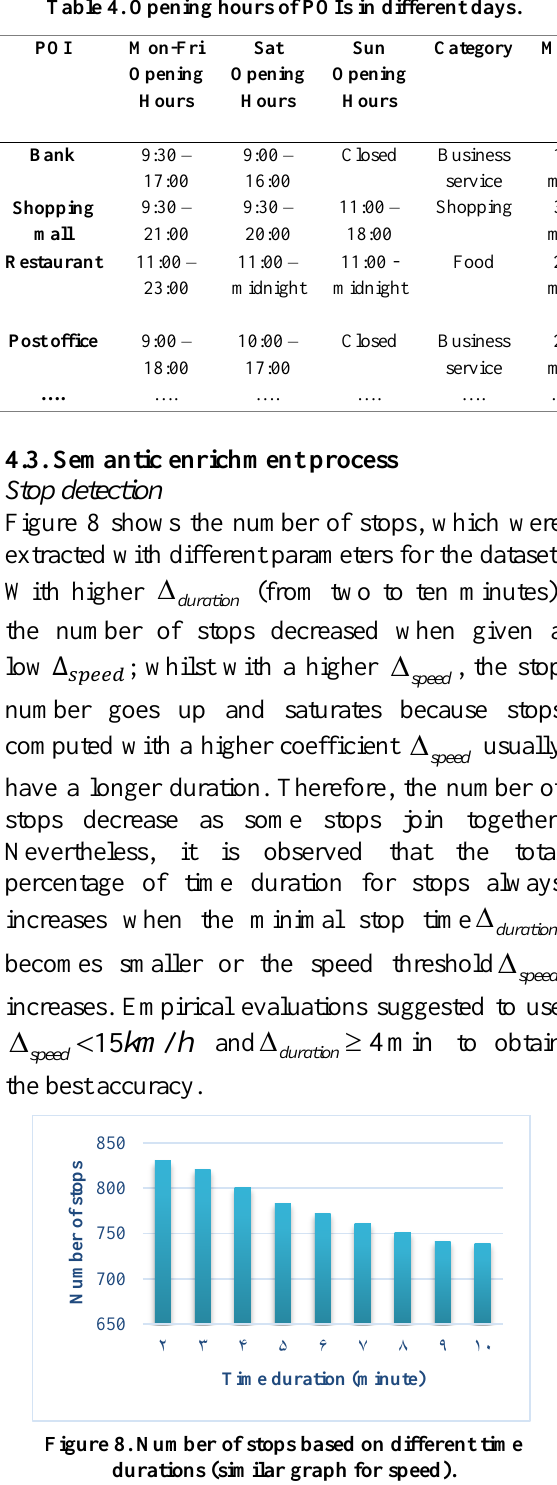
Table 4. Opening hours of POIs in different days.